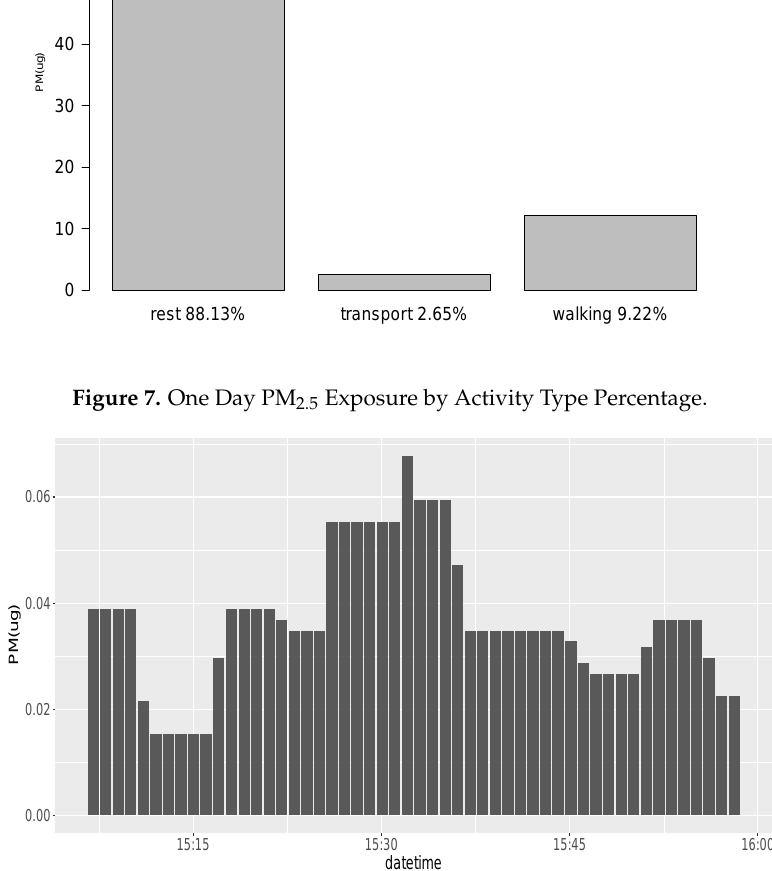
Figure 8. Indoor PM 2.5 Exposure Values Across Time. (DeltaT = 1